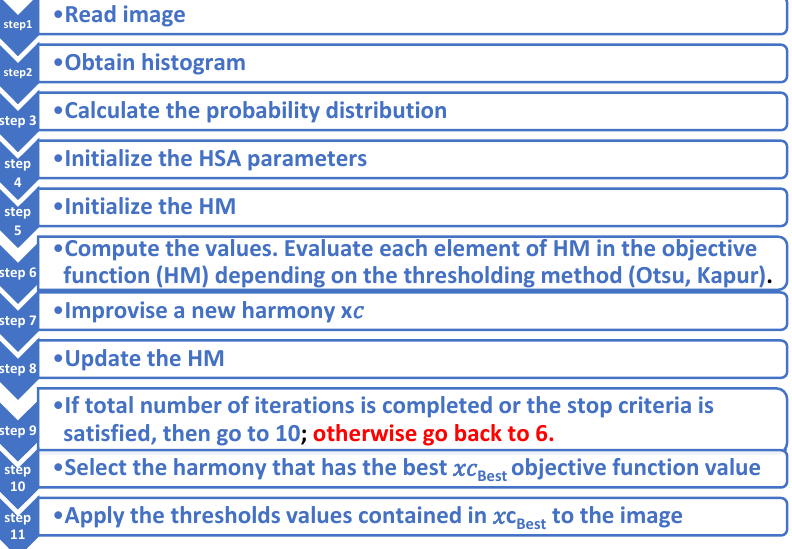
Figure 2. Developed an Algorithm describing the method used for brain segmentation. The red text in step 9 indicate the retour to step 6 if the condition in step 9 is not accomplished.